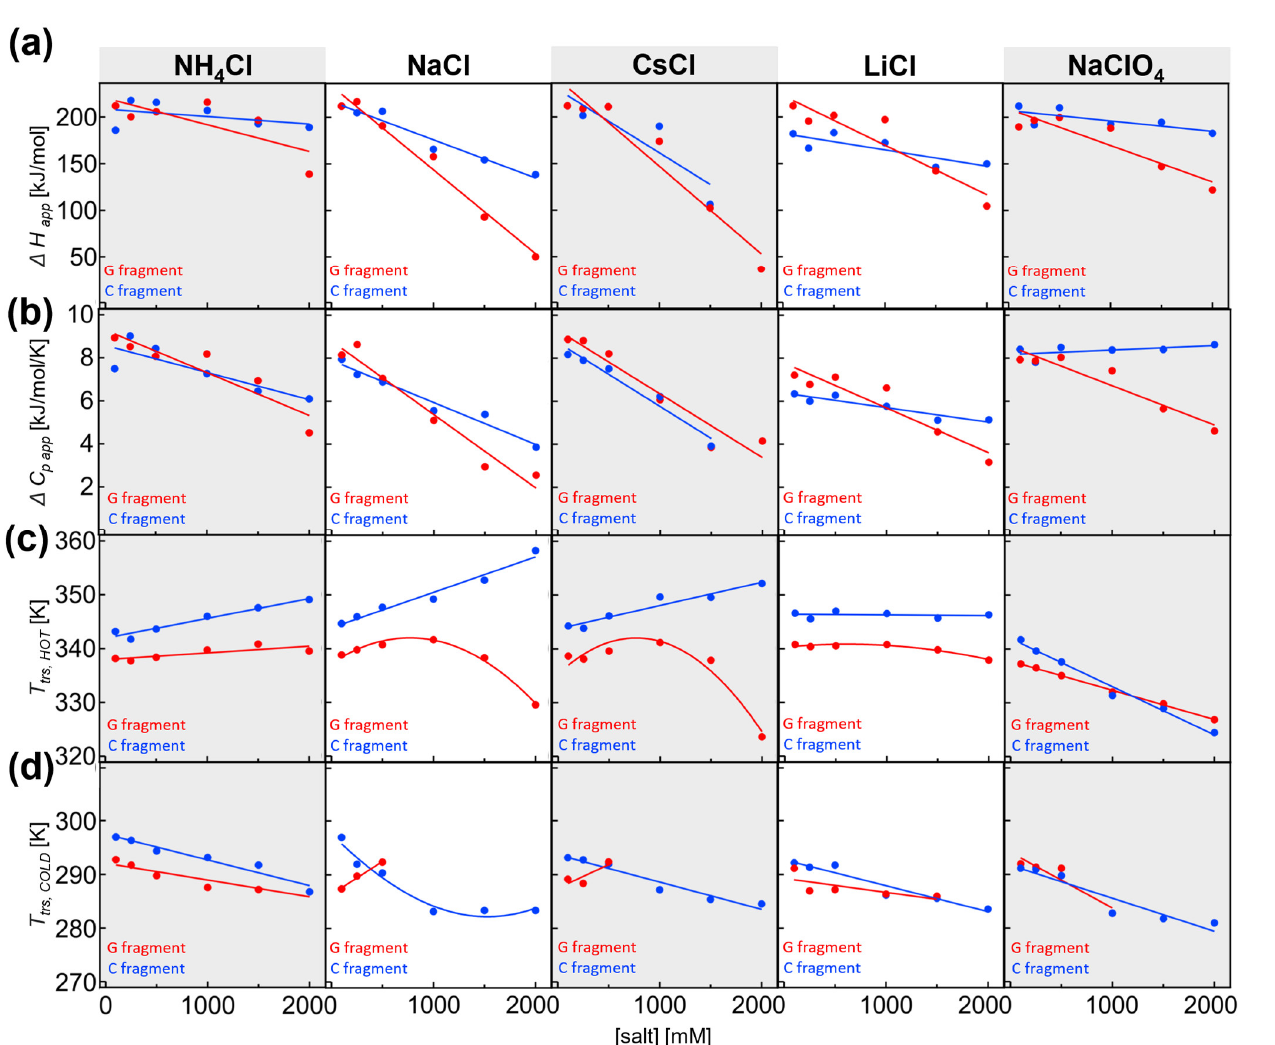
Figure 4. The thermodynamic parameters obtained from nonlinear regression of the cold and hot denaturation data: Δ H ( a ); Δ c p ( b ); T trs, hot ( c ); and ( d ) T trs, cold for G fragment (red) and C fragment (blue) in the presence of 9 M urea, and 0.1–2 M salts (NH 4 Cl; NaCl; CsCl; LiCl; and NaClO 4 ). Data were analyzed using linear regression analysis, and Pearson correlation coefficients are listed in Supplementary Table S1. In addition, the table contains the percentage of the probability Prob N (| r | ≥ r 0 ) that the correlation coefficient was observed for uncorrelated variables containing N data pairs (see [33]). The quadratic fit was applied when the residuals from linear regression analysis displayed significant trends, deviations, and/or serial correlations. The major function of the regression fits was to guide the eye and quantify the salt sensitivity of the given parameter. For residual plots, see